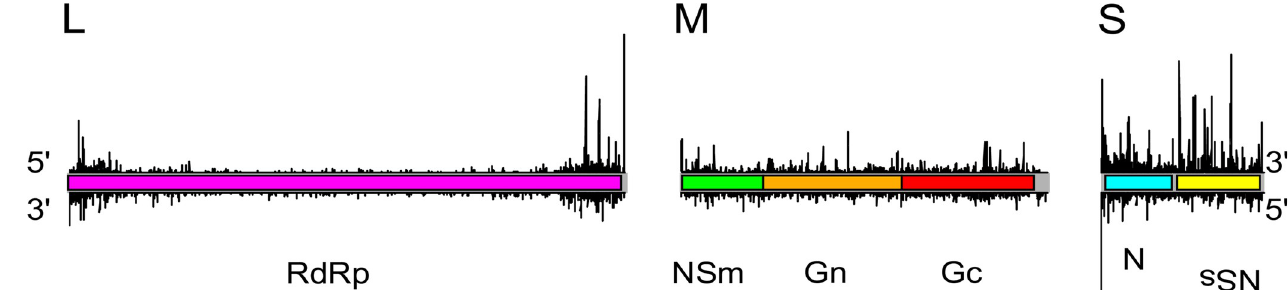
Fig 10. Summary of 21 nt vsiRNA distribution in PP9ad cells in response to rTOSV infection. These graphs show the nucleotide positions for which all three replicates had 21 nt vsiRNAs sequences starting; the data was all scaled across segments by replicate to take differences in read quantity into account and shows the mean of the triplicate. Reads mapping to antigenome on top and genome,